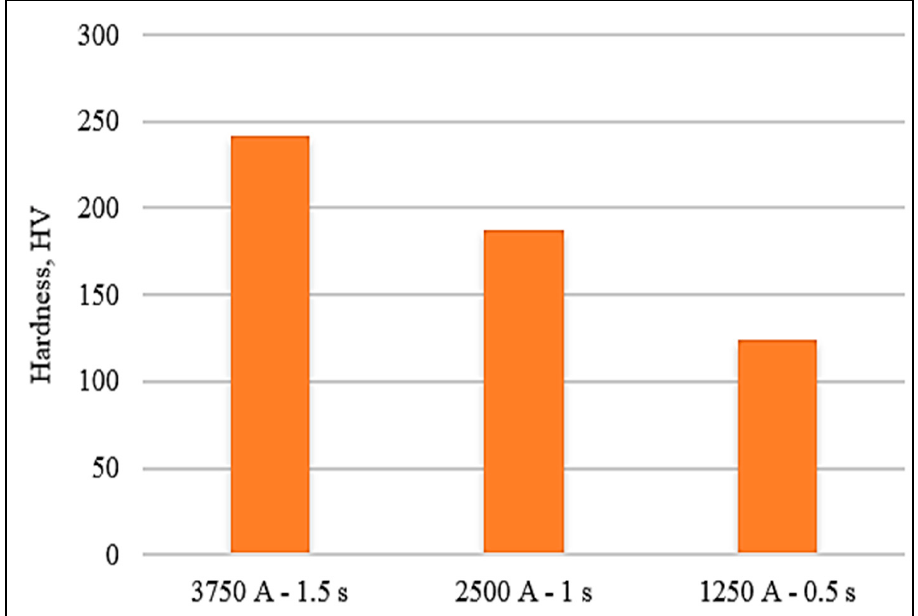
Figure 14. Micro-hardness values in HAZ of three different samples.